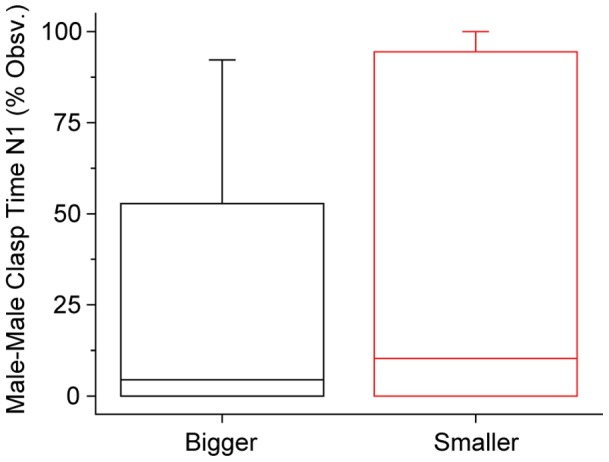
Male-male clasping cannot be explained by size discrimination.The smaller frog in a male-male pair was no more likely to clasp his partner than the bigger frog in the pair (Mann-Whitney U, p = 0.326, n = 14 per category). Box plot shows median, 25th and 75th percentiles; whiskers are 10th and 90th percentiles.